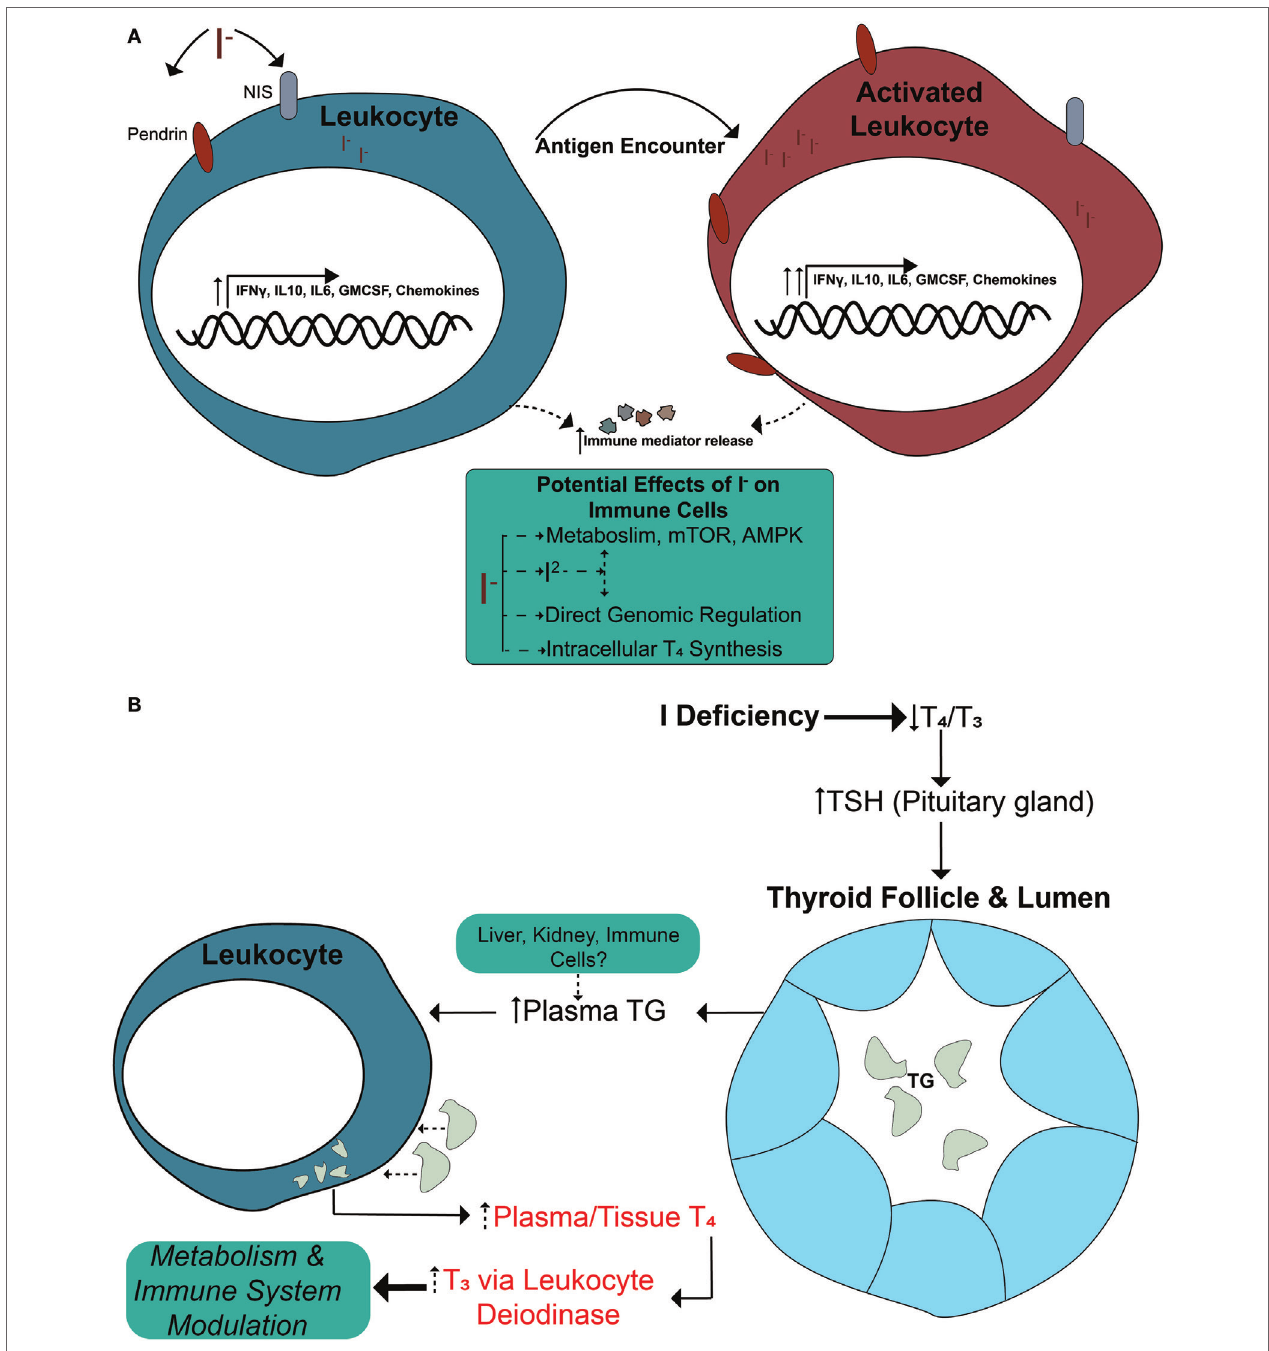
FigUre 5 | Current model—immune cells regulate their function via iodide and increase levels of thyroid hormones by processing thyroid-derived thyroglobulin (TG). (a) Immune cells express surface iodide transporters (NIS and PENDRIN) that are upregulated during cellular activation. The cells are able to accumulate iodide that could alter the transcription of multiple immune mediators and possibly other genes. The changes are functional since the higher mRNA levels correlate with increased cytokine release at the basal state. The effect is systemic and is not polarized to either pro- or anti-inflammatory genes. During an immune response, the presence of sufficient amounts of iodide allows for a “primed” state of cells that are ready to proliferate upon activation. The effects of iodide on immune cells could have an impact during early conception wherein immune cells could release more factors to support blood vessel and optimal pregnancy. (B) In an iodine deficiency state, TSH is secreted to command an increase of mostly T 4 and some T 3 by the thyroid. The thyroid responds by elevating NIS and PENDRIN surface expression and the production of more TG, some of which is released in the blood stream. Increased severity of iodine deficiency raises TG levels in the blood accordingly. Based on our findings, we propose that leukocytes could uptake TG from the blood or tissues and release T 4 , which will eventually raise T 3 levels by deiodinase activity. This has a systemic effect since it increases levels of hormones to local tissues and/or in the blood for increased metabolism. Released thyroid hormones are also known to affect the immune system by enhancing cytokine expression and altering phenotypes of immune